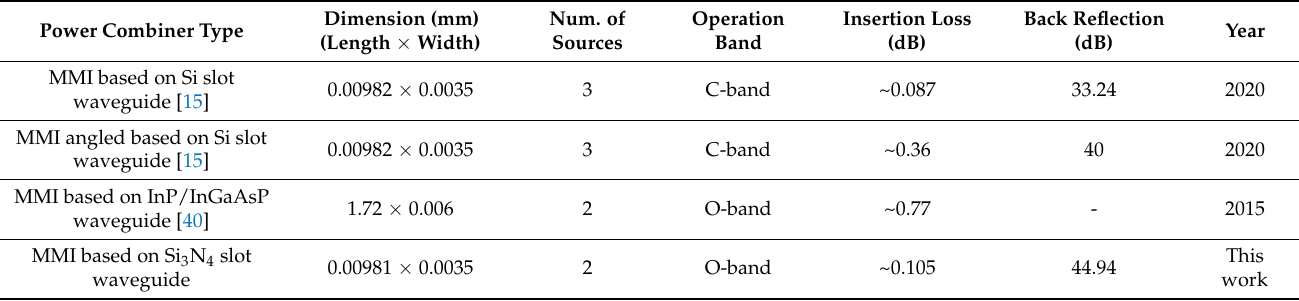
Table 1. Comparison between the main characteristics of different power